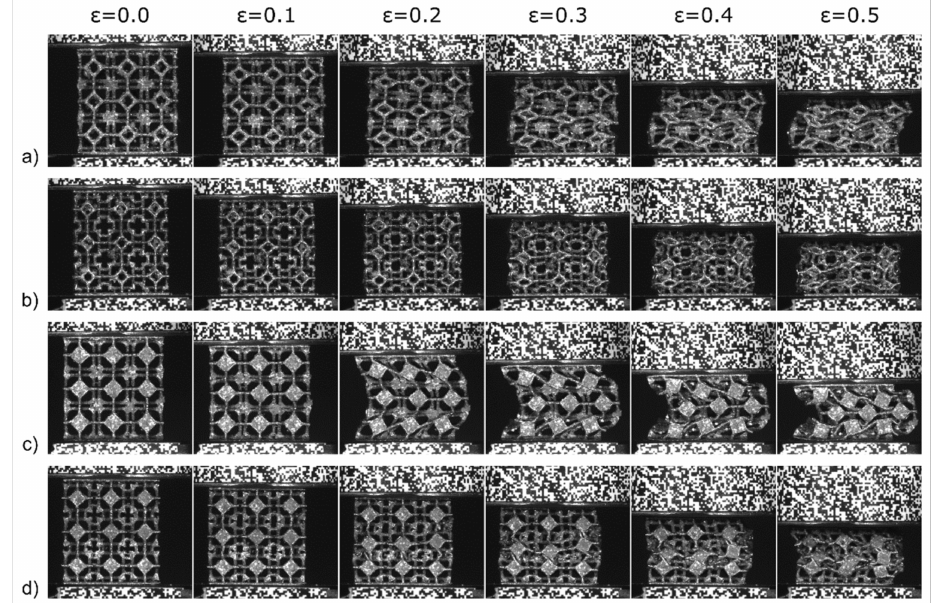
Figure 20. Deformation modes of ( a ) BD, ( b ) BS, ( c ) FD, ( d ) FS re-entrant tetra-kai-decahedral structure